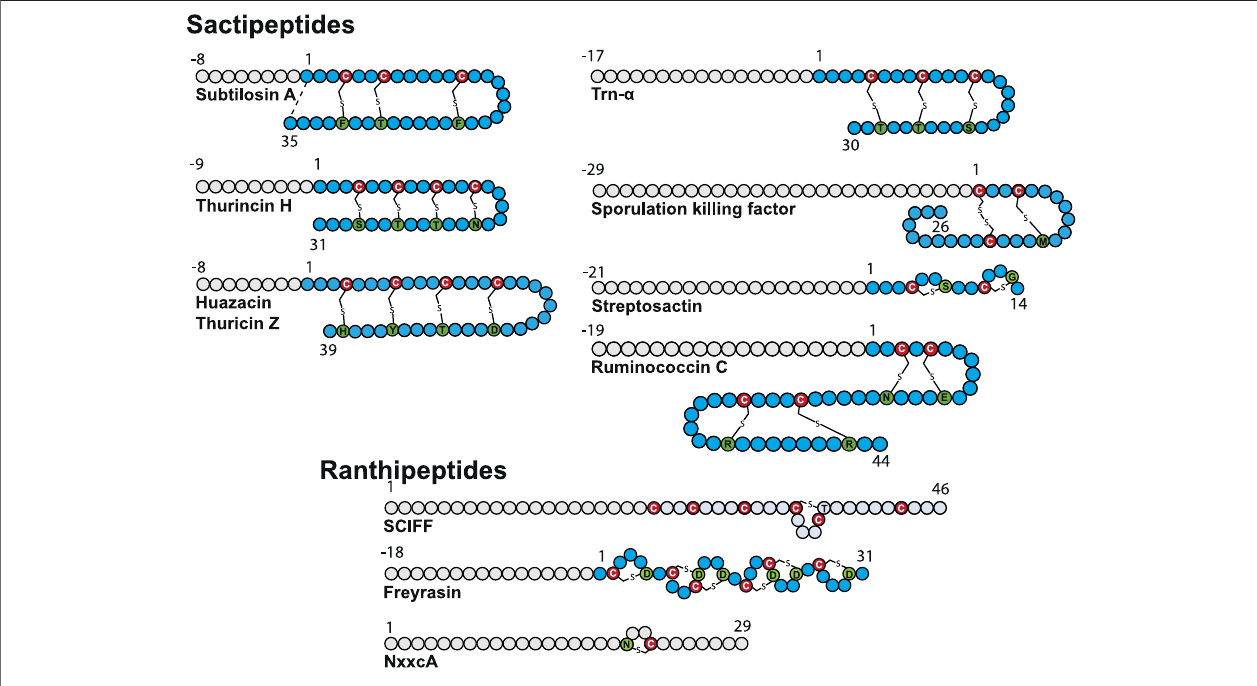
FIGURE 3 | Structure of sactipeptides and ranthipeptides. Circles in gray and blue represent amino acid from the leader peptide and the core sequence, respectively. The donor cysteine residues are indicated by a red circle, and acceptor amino acid residues are depicted in green.